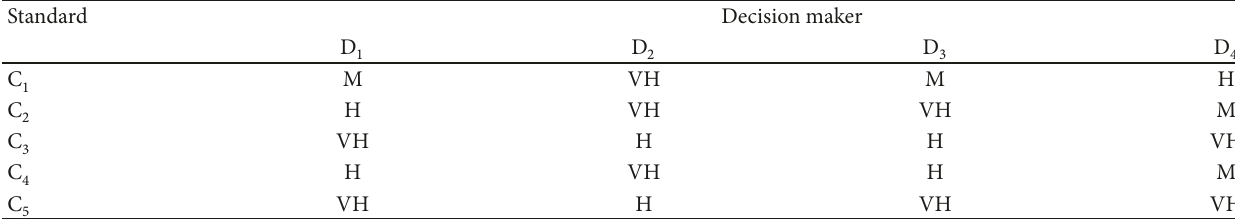
Table 3: Importance weight of attributes.